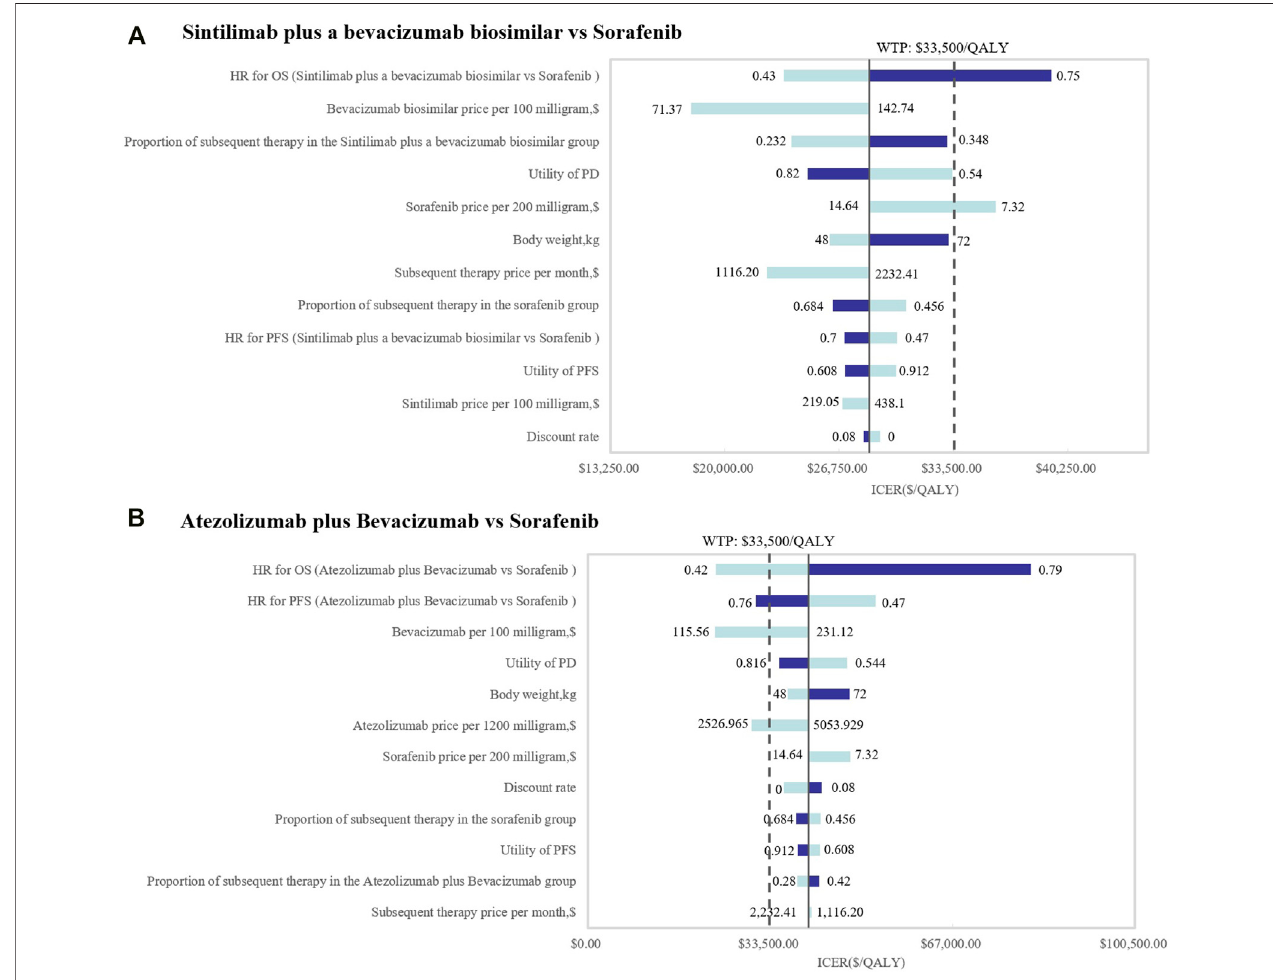
FIGURE5| Tornadodiagramsofthescenarioanalysis.One-waydeterministicsensitivityanalysesof (A) SBand (B) ABincomparisonwithsorafenibinthescenario analysis.OS,overallsurvival;PFS,progression-freesurvival;HR,hazardratios;PD,progressivedisease;ICER,incremental cost-effectiveness ratio;SB,sintilimabplusa bevacizumab biosimilar (IBI305); AB, atezolizumab plus bevacizumab; WTP, willingness-to-pay; QALY, quality-adjusted life year.